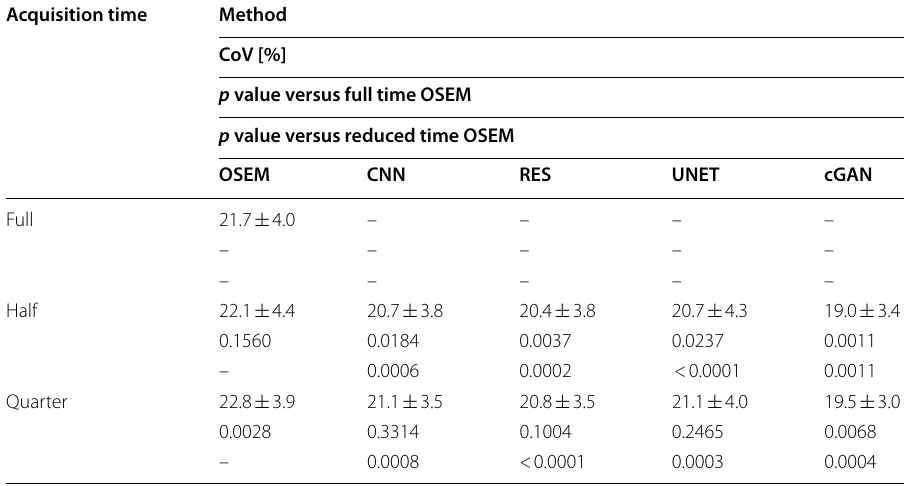
Table 2 Coefficient of variation (mean methods and acquisition times at rest